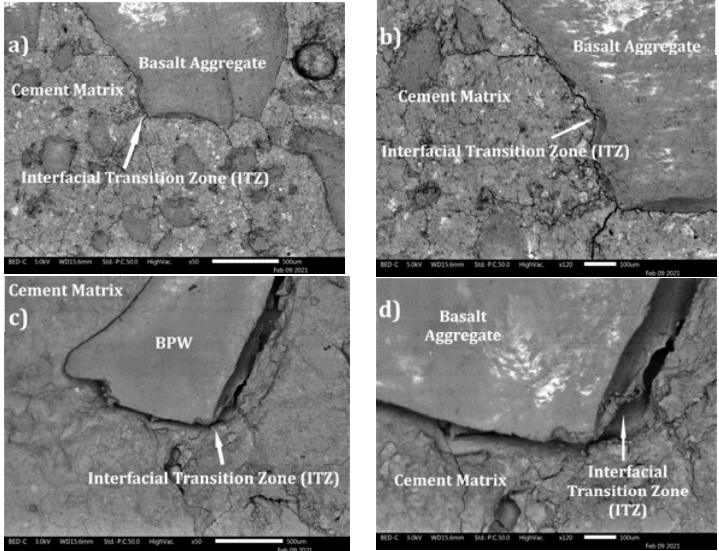
Figure 7. SEM micrographs of the interfacial zone between the natural aggregate ( a , b ), BPW ( c , d ), and the cement matrix.